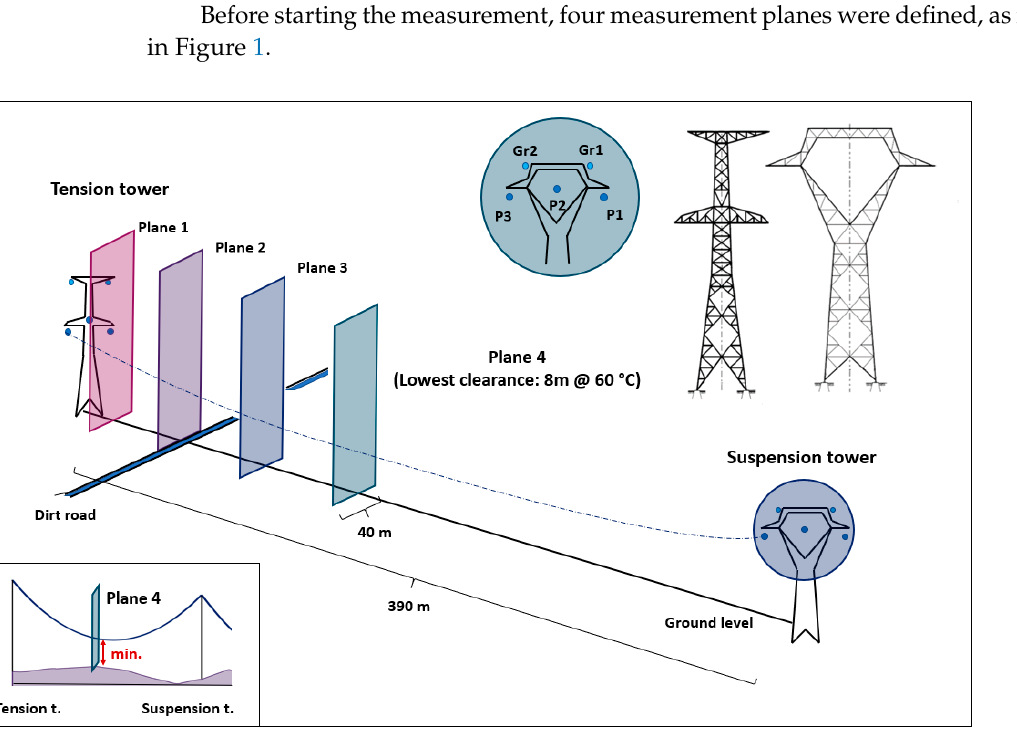
Figure 1. Measuring positions in the selected span.